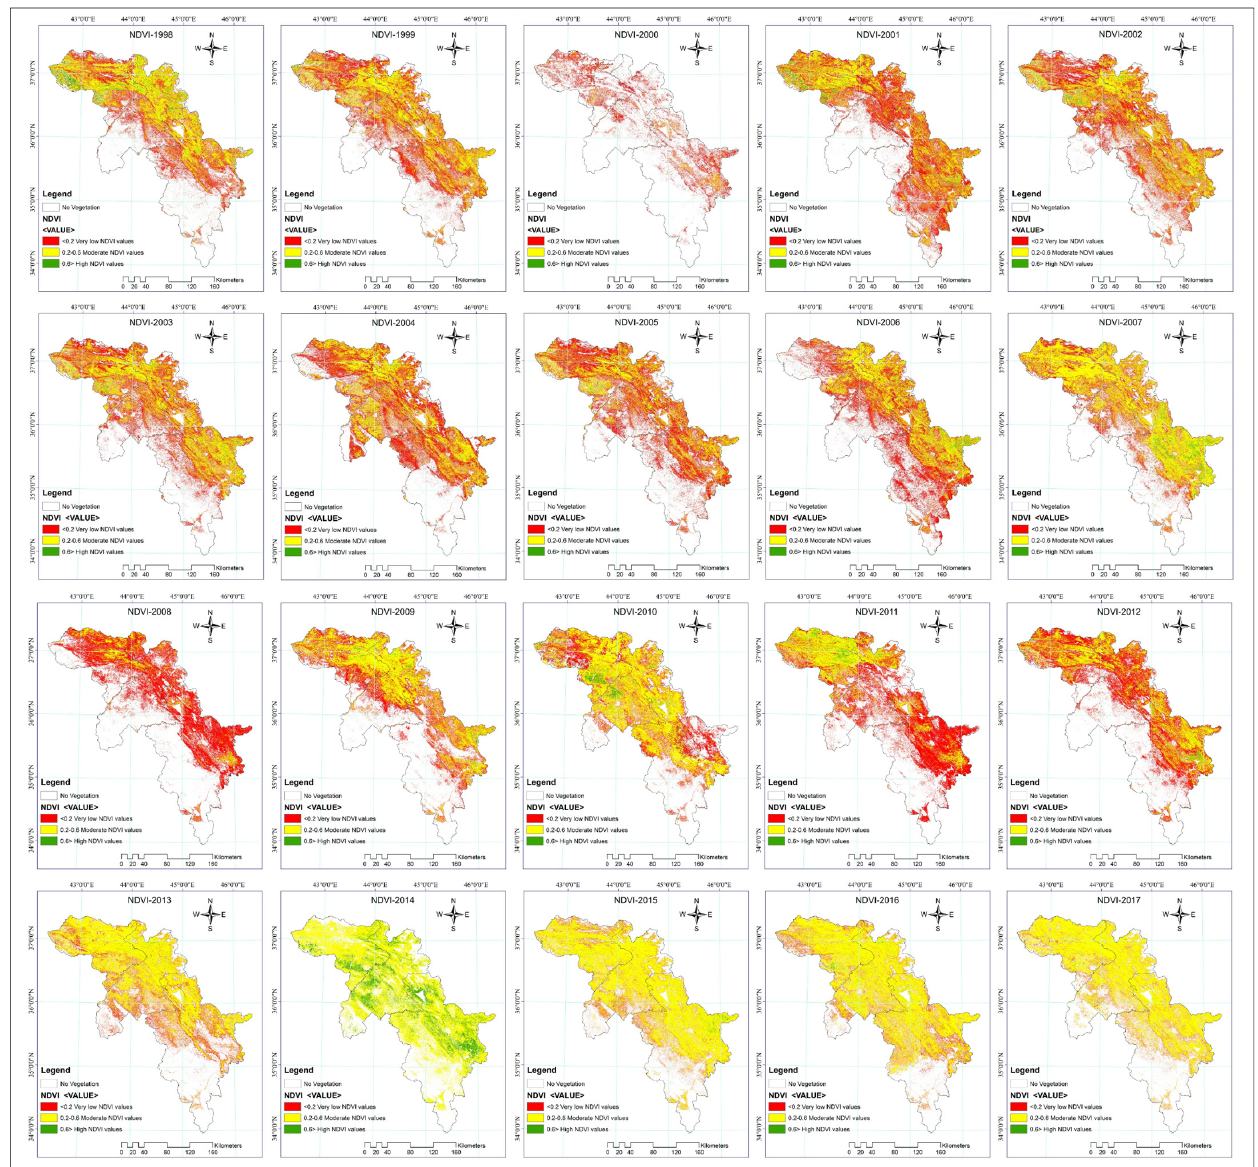
Figure 4. Spatial Variation of the NDVI-Based Vegetation in 1998 to 2017. The NDVI values were the lowest in the southwest and west parts of the region compared to the northeastern parts, with higher vegetation and a higher NDVI value (Figure 4). There was a significant decline in annual rainfall averages in some sites in KRI compared to rainfall averages of the other studied locations from 1998 to 2017. Figures 5 and 6 shows the minimum values of NDVI-based vegetation cover due to the changes in precipitation rates, whereas precipitation averages were low in some locations (Table 1). On the other side, the precipitation averages were high in some sites, which positively reflected the increase in NDVI values (Figure 4). Low precipitation and high temperature play a negative role in decreasing NDVI values and vegetation cover in the southwest parts of KRI during growing